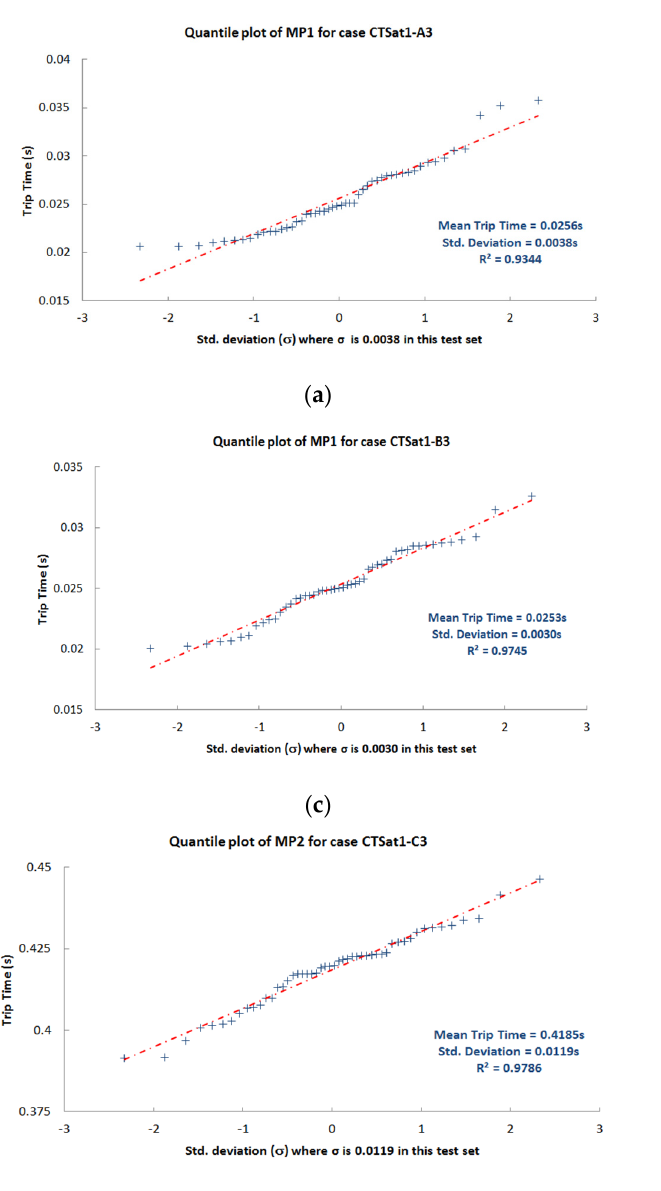
Figure 20. Quantile plot for cases: ( a ) MP1 CTSat1-A3 (light CT saturation, no faulty components, L-L-G fault at 100% of the feeder); ( b ) MP1 CTSat2-A3 (deep CT saturation, no faulty components, L-L-G fault at 100% of the feeder); ( c ) MP1 CTSat1-B3 (light CT saturation, 1 faulty fibre, L-L-G fault at 100% of the feeder); ( d ) MP1 CTSat2-B3 (deep CT saturation, 1 faulty fibre, L-L-G fault at 100% of the feeder); and ( e ) MP2 CTSat1-C3 (light CT saturation, 1 faulty AMU, L-L-G fault at 100% of the feeder).